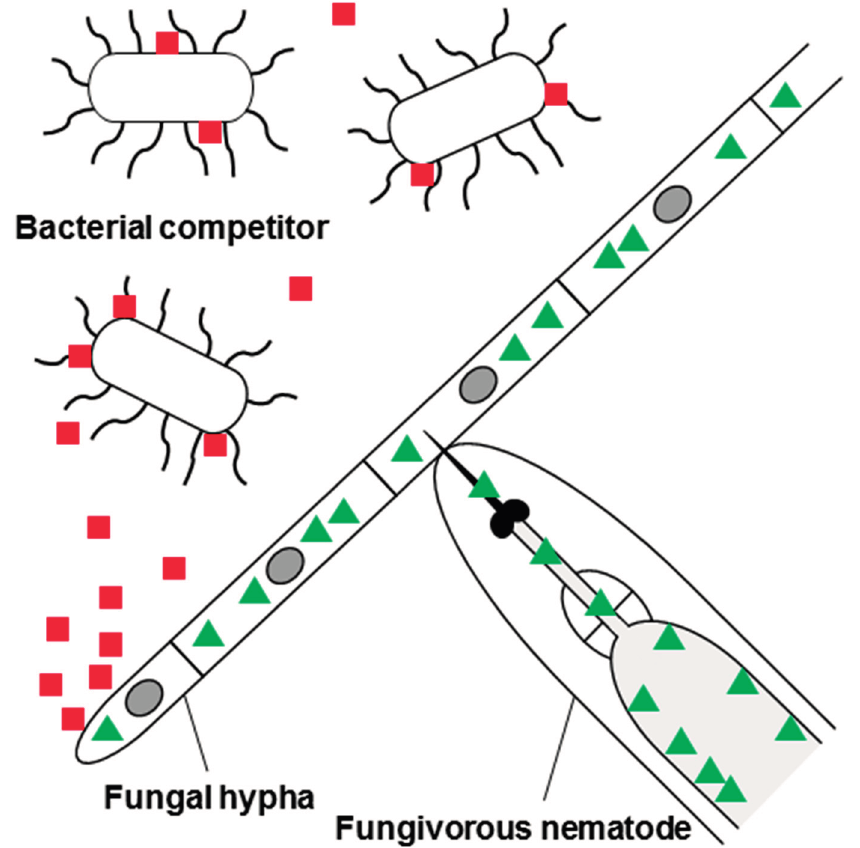
Figure 1. Hypothesis on the localization of glycan-binding fungal defense effector proteins in relation to the type of antagonist. Fungal effector proteins against bacterial competitors (red squares) are secreted and bind to surface glycoepitopes of the bacterial cells, whereas effector proteins against predatory nematodes (green triangles) are kept in the cytoplasm of the fungal cells, ingested by the nematode upon feeding and bind to surface glycoepitopes of intestinal epithelial cells of the nematode. See text for